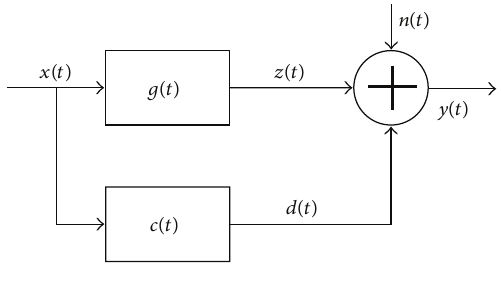
Figure 6: Signal model of a target ensemble in ground clutter.